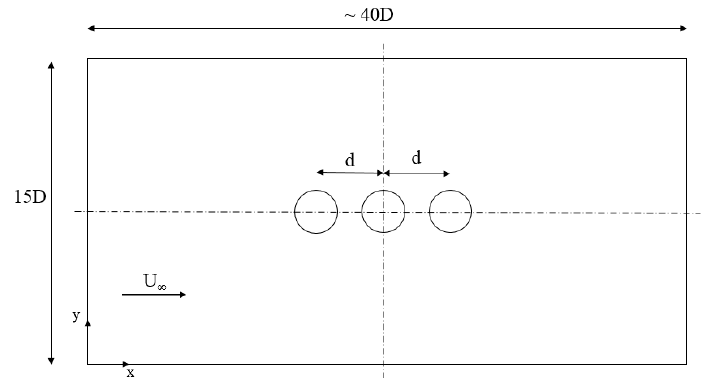
Figure 2. Problem setup and arrangement of the three cylinders.